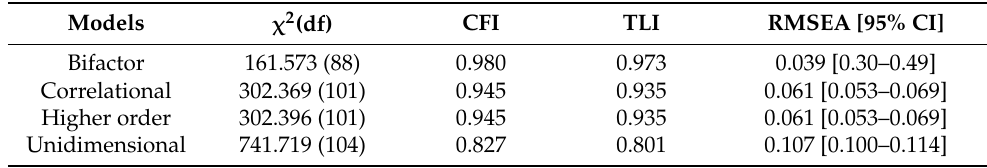
Table 2. The Gratitude Resentment and Appreciation Test-Revised Short (GRAT-RS): confirmatory factor analysis with weighted least squares means and variance adjusted (WLSMV) estimation. Fit indexes ( n = 537).